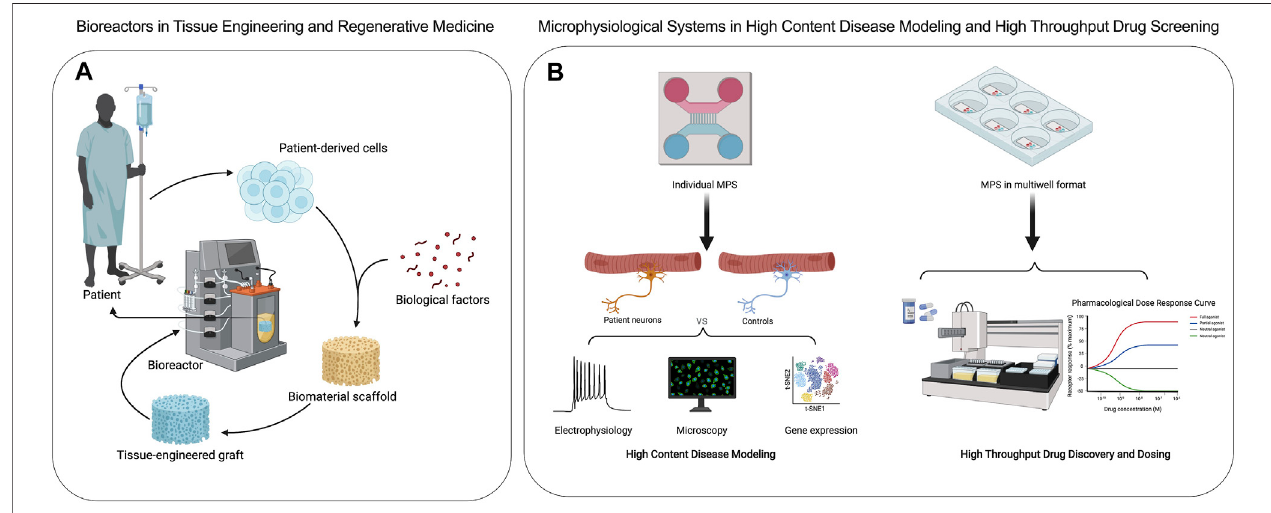
FIGURE 2 | Applications of bioreactors and microphysiological systems are distinct. (A) Bioreactors are used to create engineered transplantable tissue grafts in tissue engineering and regenerative medicine. (B) Microphysiological systems are used in high content disease modeling and high throughput drug discovery and screening of ef fi cacy and